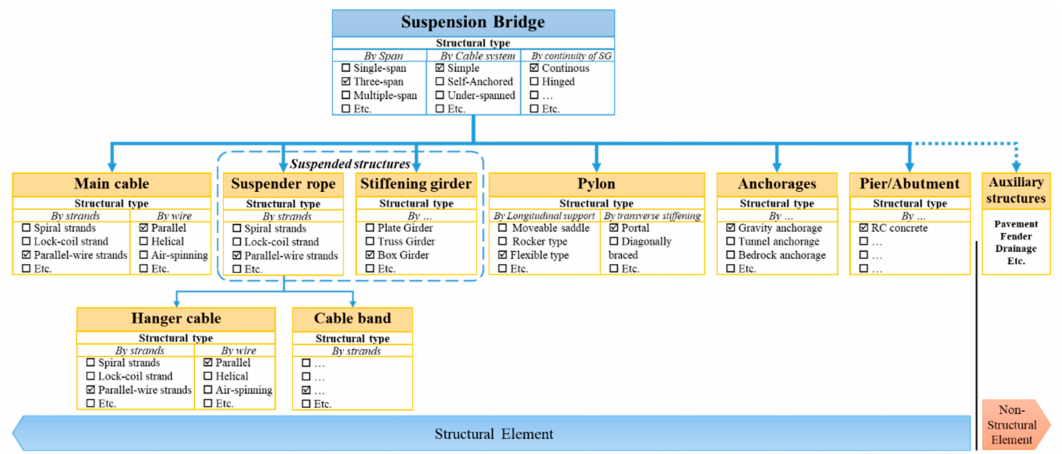
Figure 1. Example of a structural classification for suspension